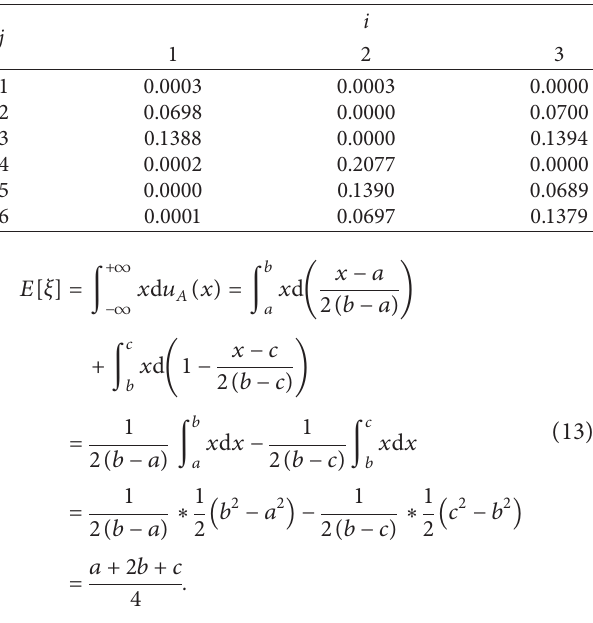
Table 5: Simulation results of heavy truck